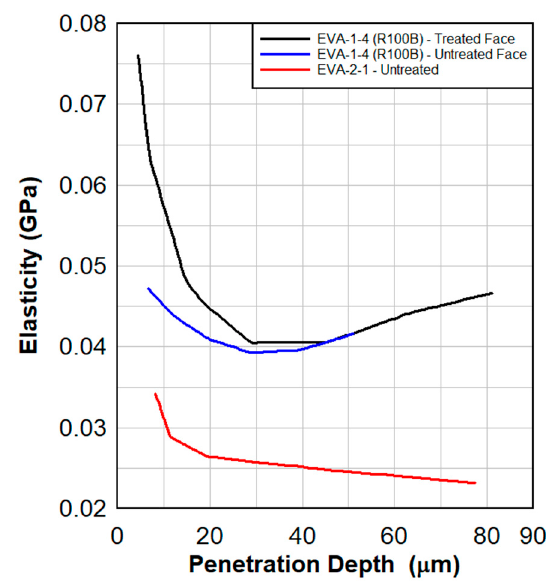
Figure 13. Elasticity as a function of the penetration depth for the radiated and virgin EVA specimens. Treated material shows a significant elasticity in the first 10 µm of the surface.